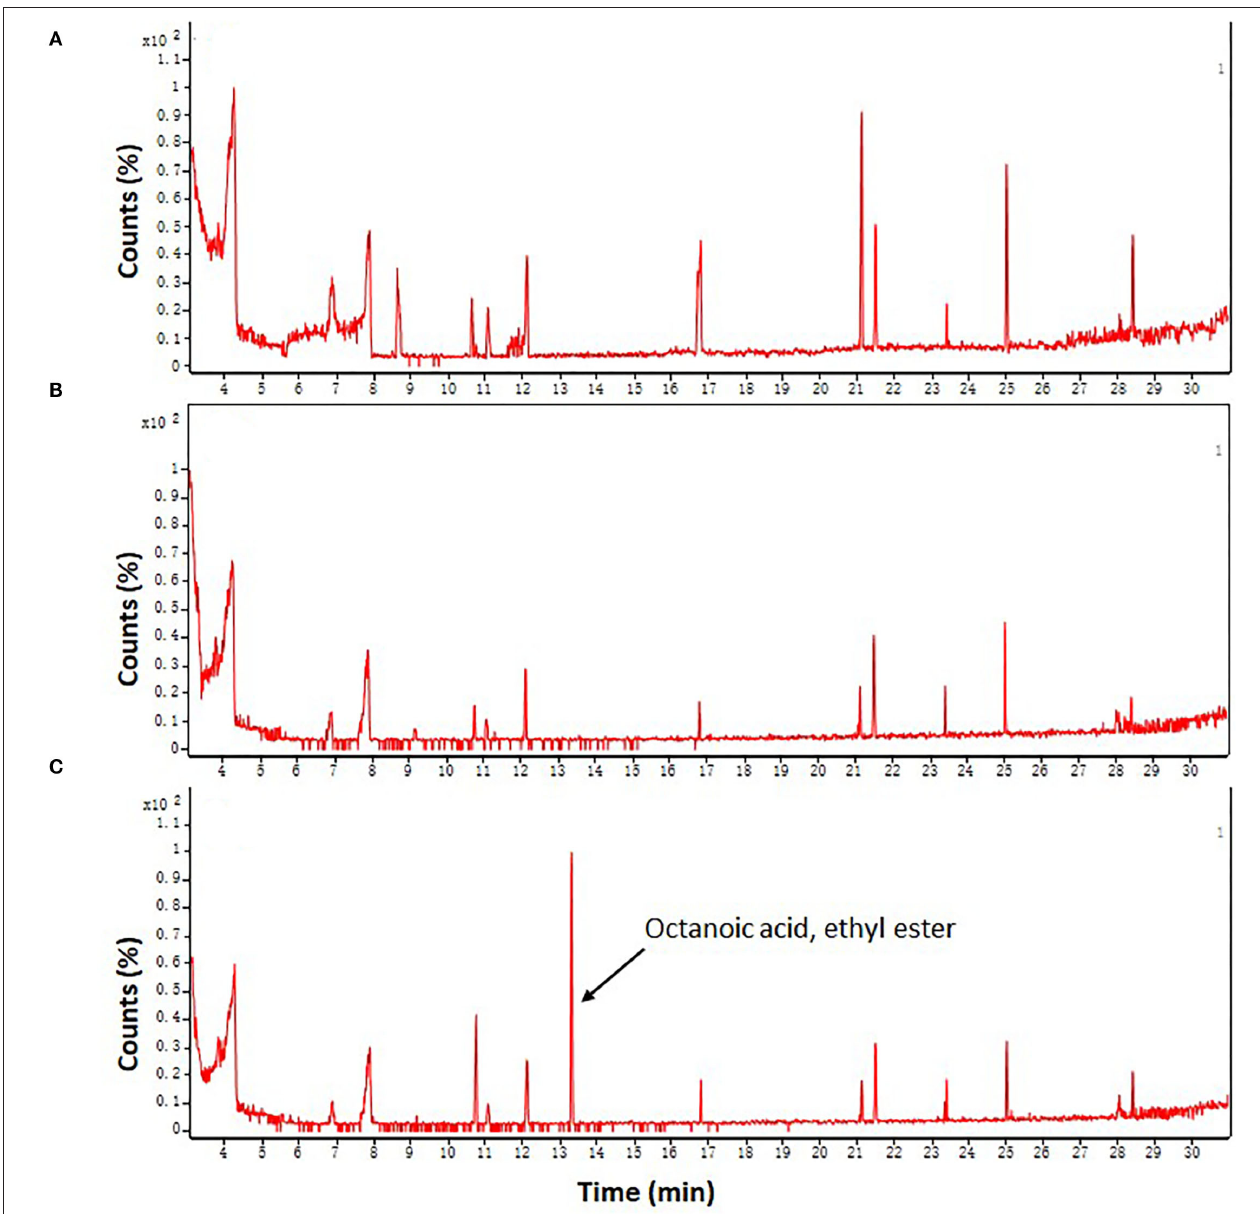
FIGURE 7 | Plots of FID chromatogram of fresh-cut taros using a GC-MS system. (A) Fresh samples from 0 day of storage; (B,C) DW-treated and FA-treated samples from 12 days of storage at 5 ◦ C, respectively. Each sample was repeatedly analyzed three times. The representative plot shown were obtained from three replications.